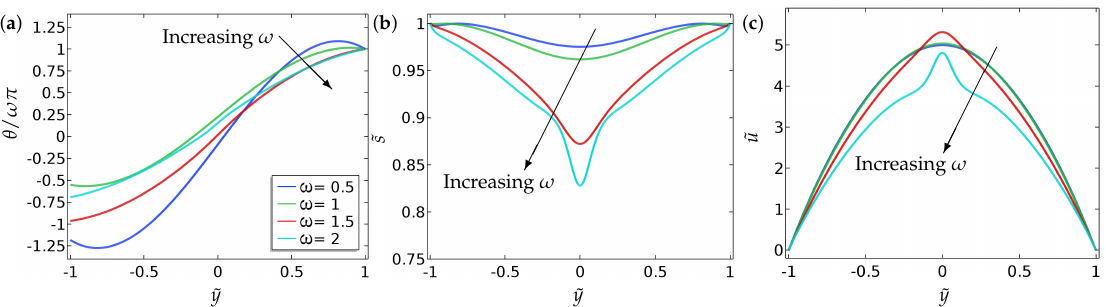
Figure 7. The effect of the winding number ω on ( a ) the director orientation ( θ ), ( b ) the order parameter (˜ s ) and ( c ) the velocity ( ˜ u ), at equilibrium ( ˜ t = 10 ) . In this case, we have considered the asymmetric boundary condition in θ (Equation (16)). The values of the parameters used are B = 1/3, L ∗ = 10 − 3 , ˜ p x = 10, L 2 = 1, and L 1 = 10 − 6 . The legends of all the sub-figures are the same as in ( a −